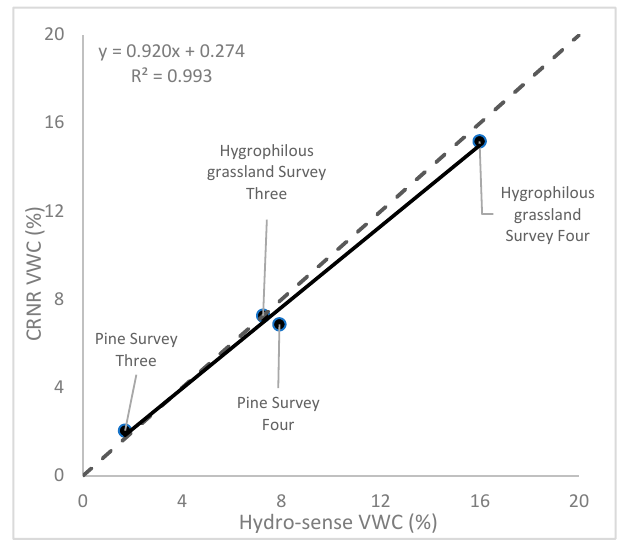
Figure 9. Average hydro-sense and CRNR VWC (%) survey values.